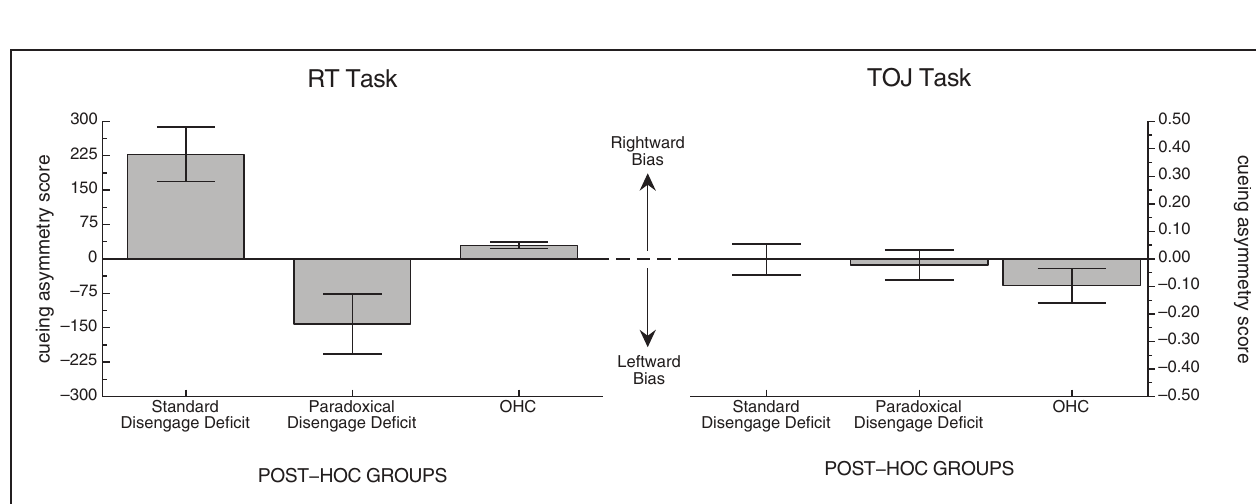
FIGURE 6 | Mean cueing asymmetry scores in each task for the post-hoc groups. OHC group is included for reference. See text for details.